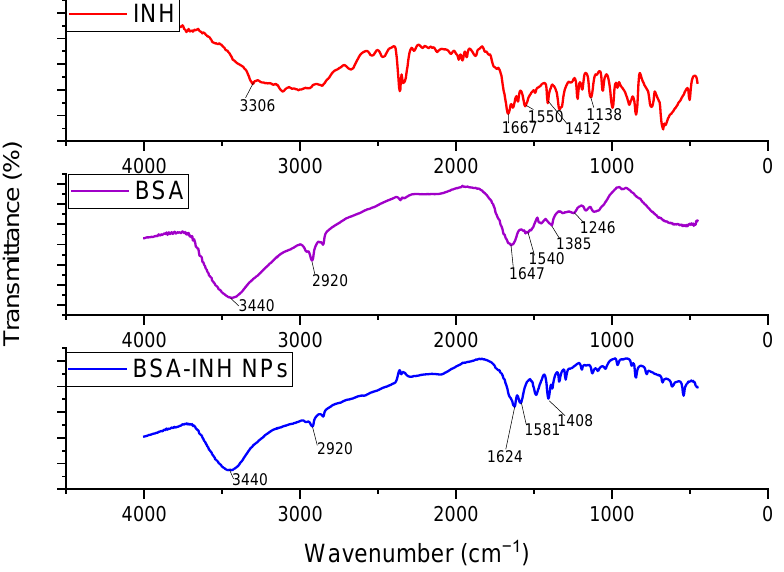
Figure 5. Thermogravimetric ( a ) and differential scanning calorimetry ( b ): INH; BSA; BSA-INH NPs.